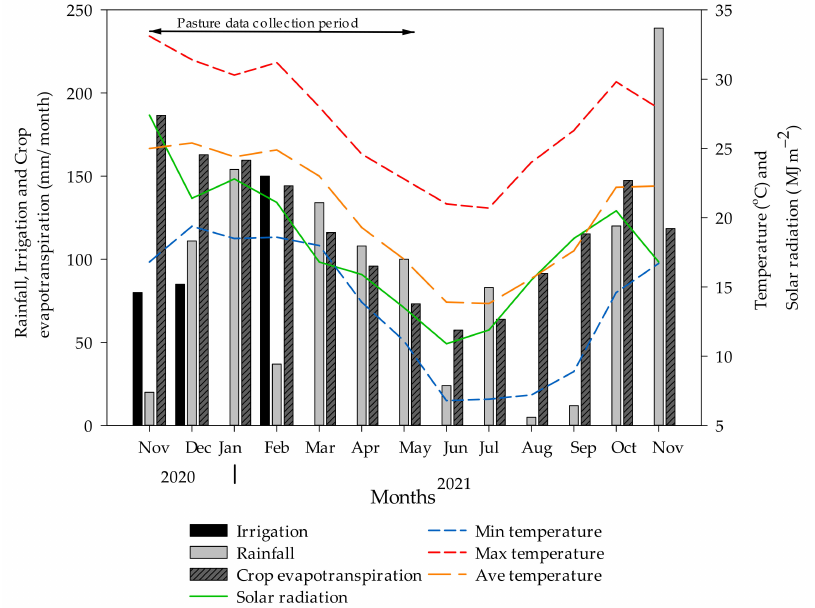
Figure 1. Monthly average weather data at the Gatton Research Dairy, Queensland, Australia from November 2020 to November 2021. Rainfall, irrigation, and temperature data were collated from an automatic weather station at the experimental site and evapotranspiration and solar radiation data were collated from the University of Queensland, Gatton, located 0.9 km from the experimental